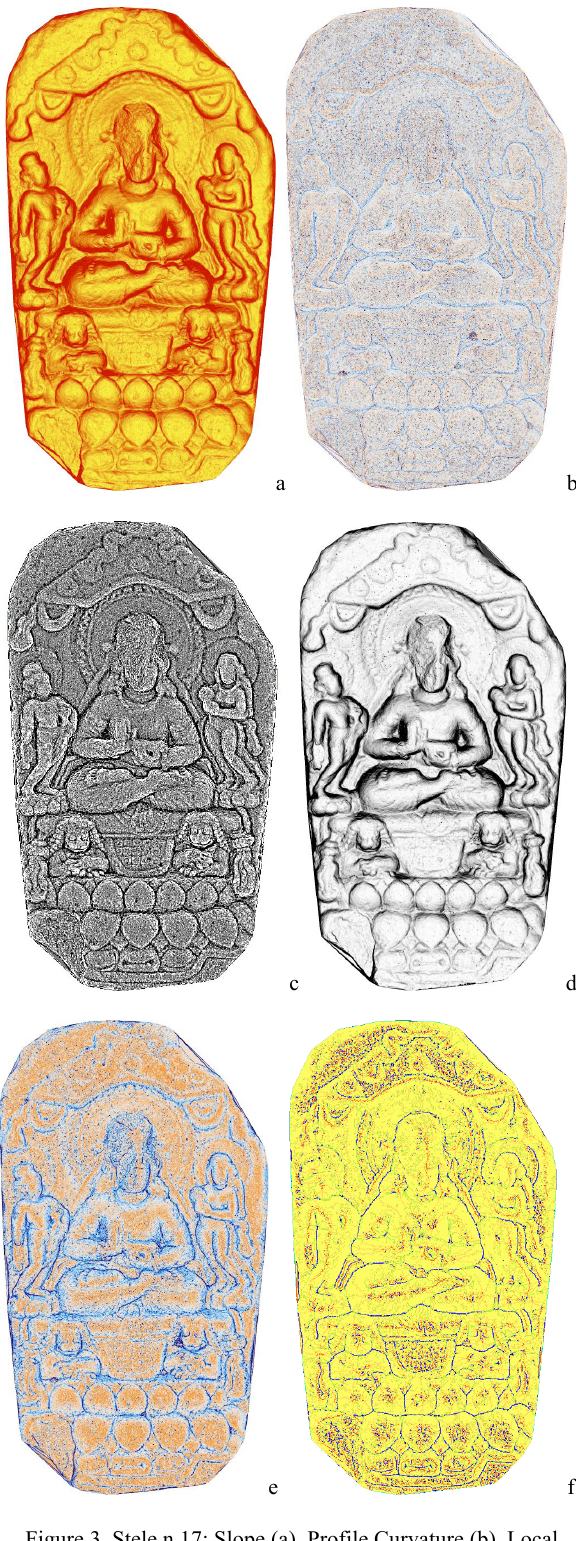
Figure 3. Stele n.17: Slope (a), Profile Curvature (b), Local Relief Model (c), Sky View Factor (d), Positive Openness (e) and Geomorphons (f).